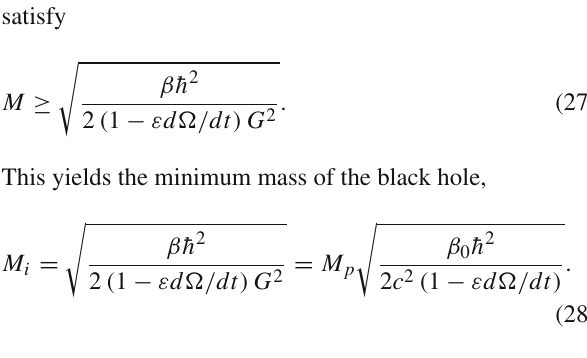
Fig. 1 Plot of the temperature versus the mass for different β . Green dashed curve corresponds to b = 0 . 5 and β = 0, red curve corresponds to b = 0 . 5 and β = 1